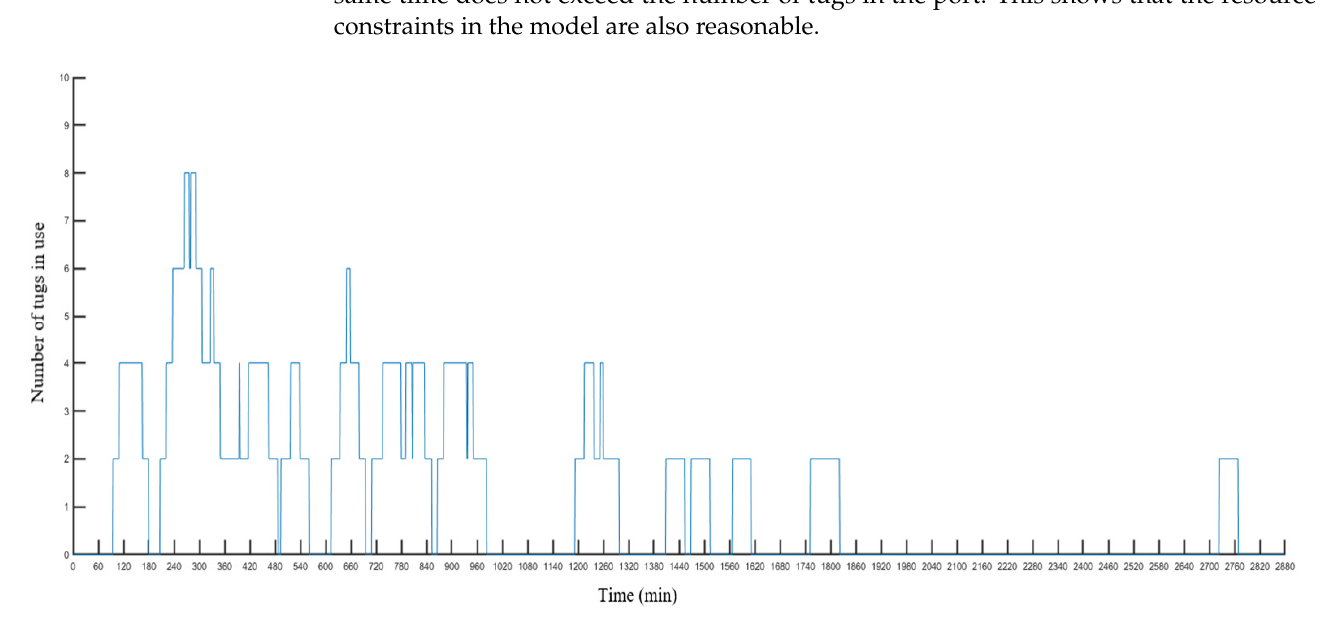
Figure 11. Number of tugs scheduled to operate at different